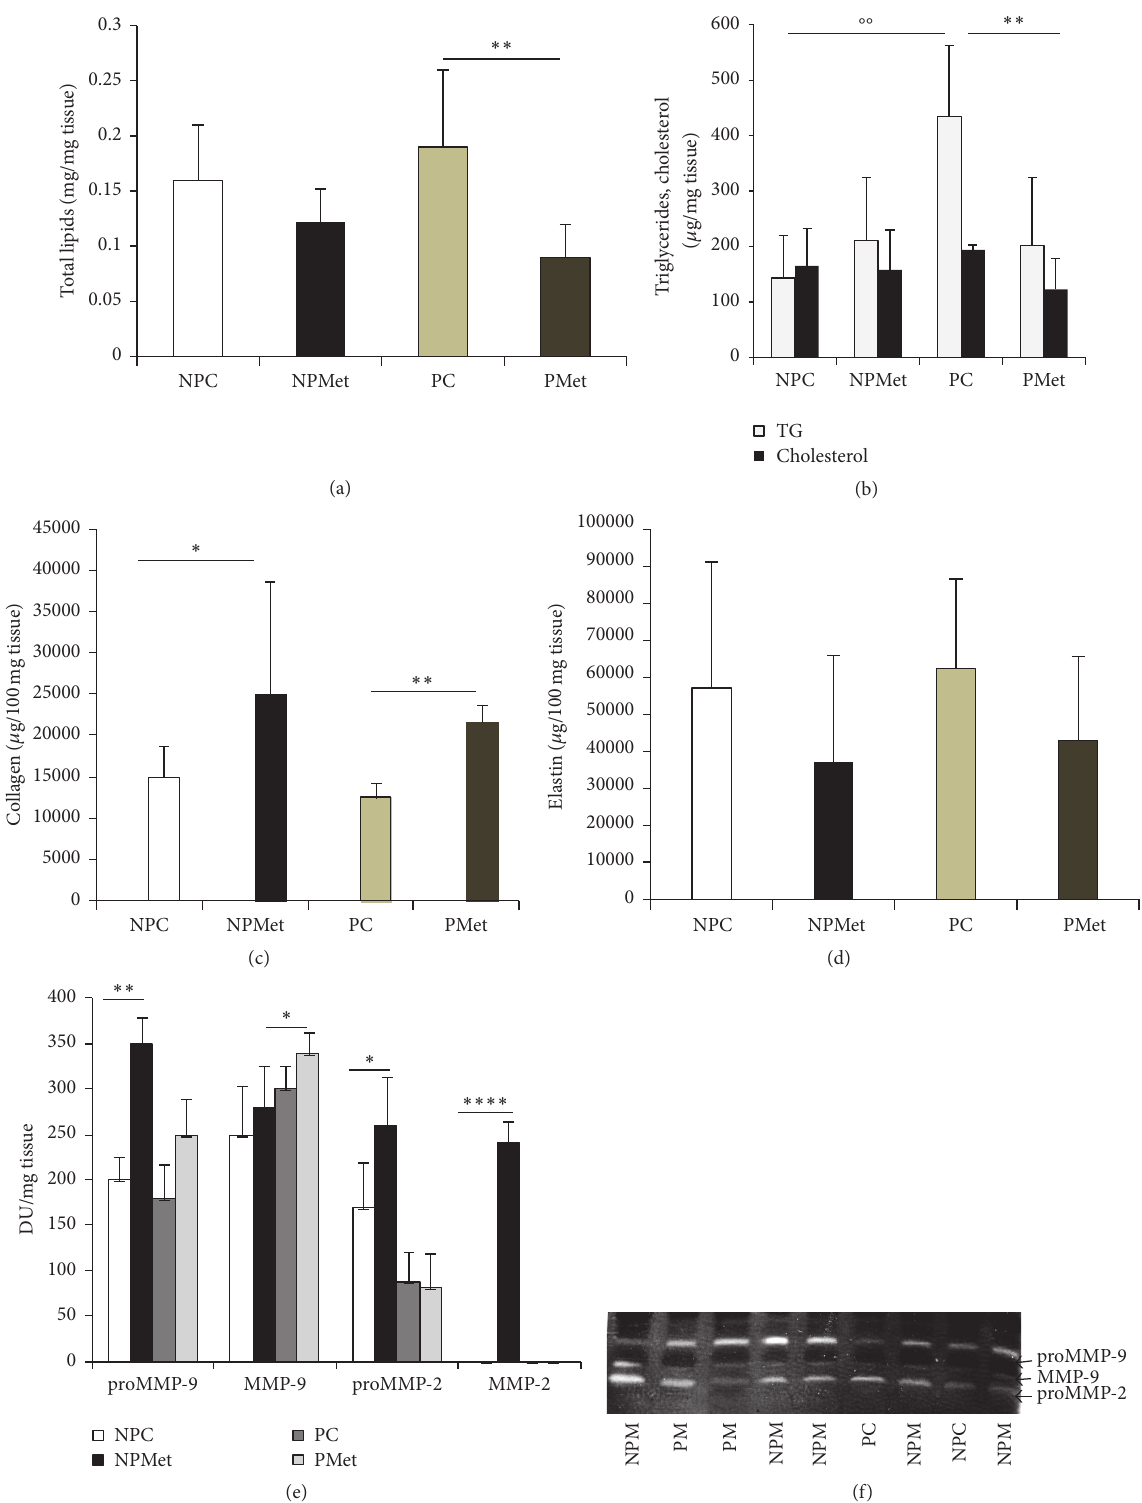
Figure 3: Lipid, collagen, and elastin levels and MMP activities of aorta from different female rabbits groups. NP: nonpregnant control, NPMet: nonpregnant with Met, PC: pregnant control, and PMet: pregnant with Met. Comparison of NPMet versus NPC and PMet versus PC ( ∗ 𝑝 < 0.05 , ∗∗ 𝑝 < 0.01 , and ∗∗∗∗ 𝑝 < 0.0001 ). The symbol “ ∘∘ ” means that the comparison is made between pregnant control TG and nonpregnant control